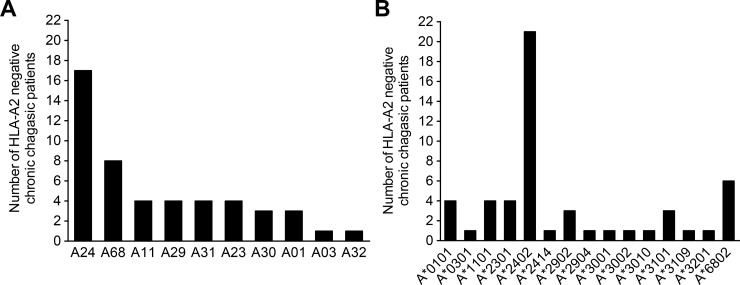
HLA typing of chronic chagasic patients with TcTLE-specific CD8+ T cells.HLA-A types (A) and sub-types (B) of chronic chagasic patients with TcTLE peptide-specific CD8+ T cells. The figure shows the number of patients with each HLA-A type and sub-type.